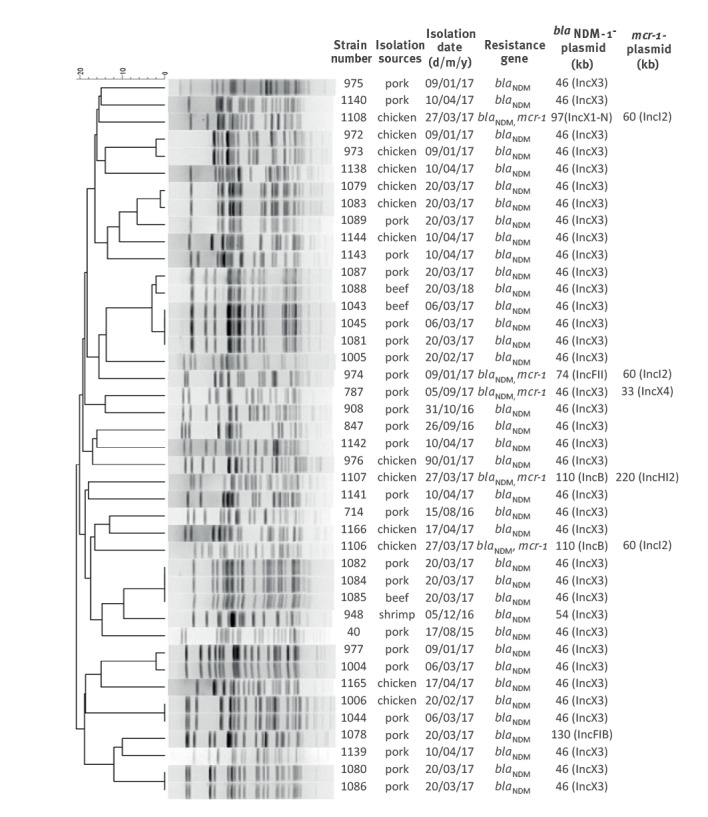

XbaI-PFGE pattern of Escherichia coli isolates resistant to meropenem, Shenzhen, 2015–2017 (n = 42)